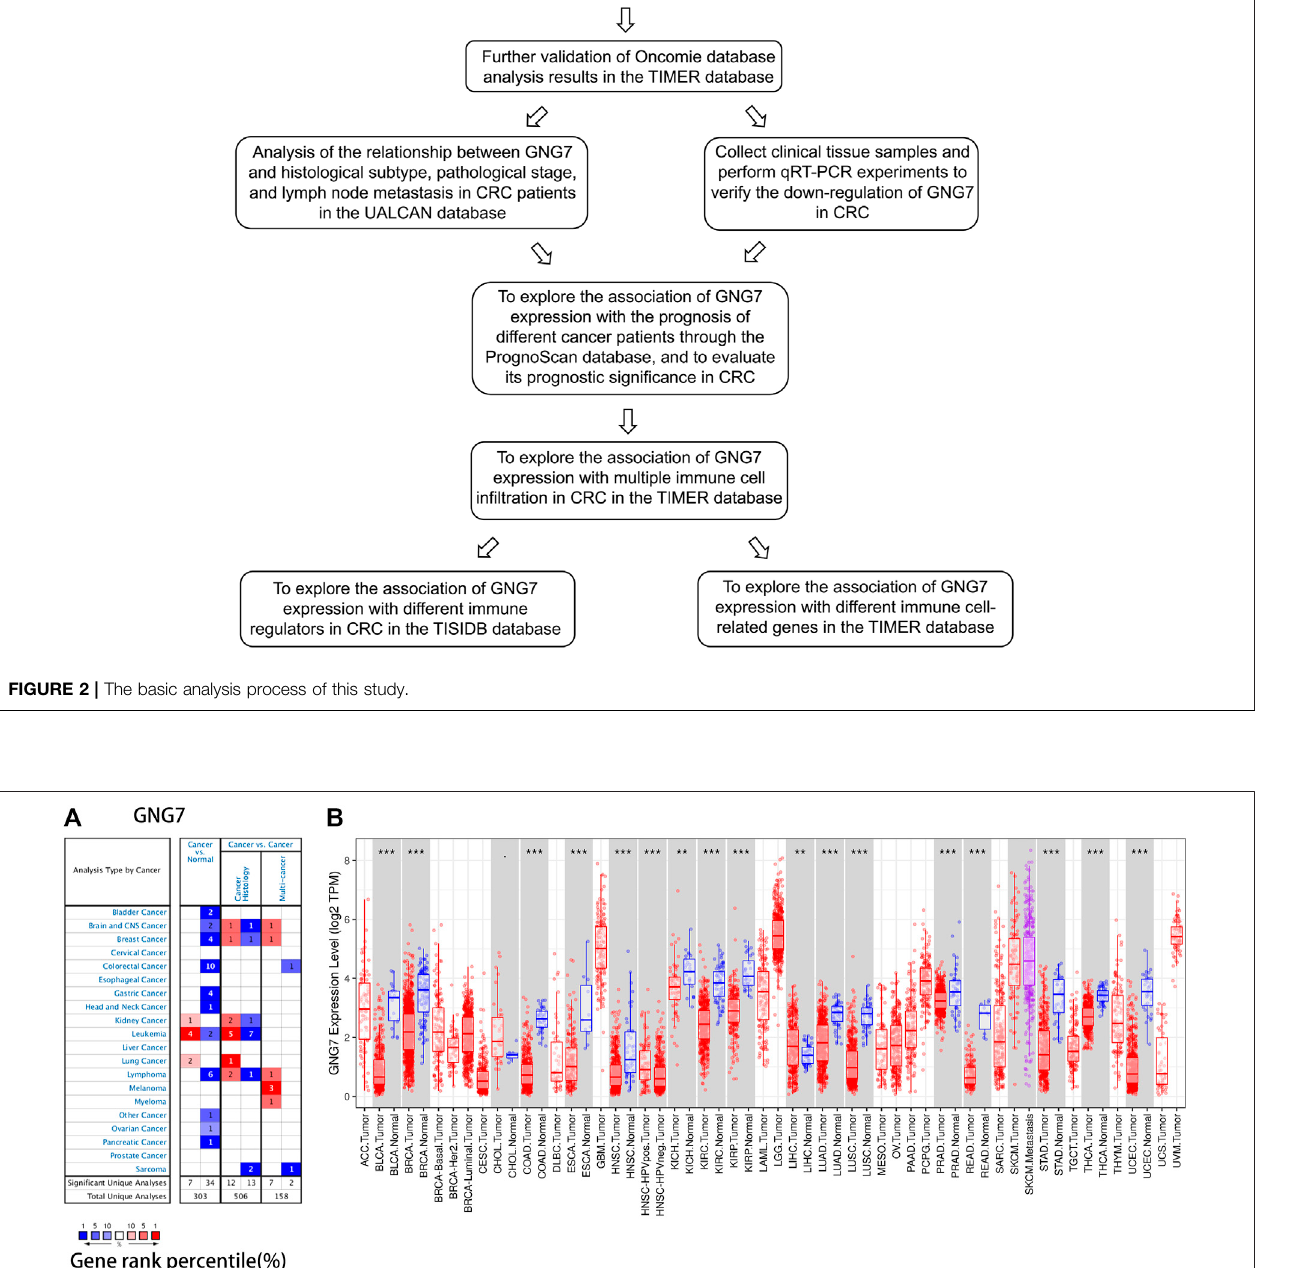
bladder cancer, brain and CNS cancer, breast cancer, colorectal cancer, gastric cancer, head and neck cancer, leukemia, lymphoma, ovarian cancer and pancreatic cancer ( Figure 3A , Supplementary Table S1 ).